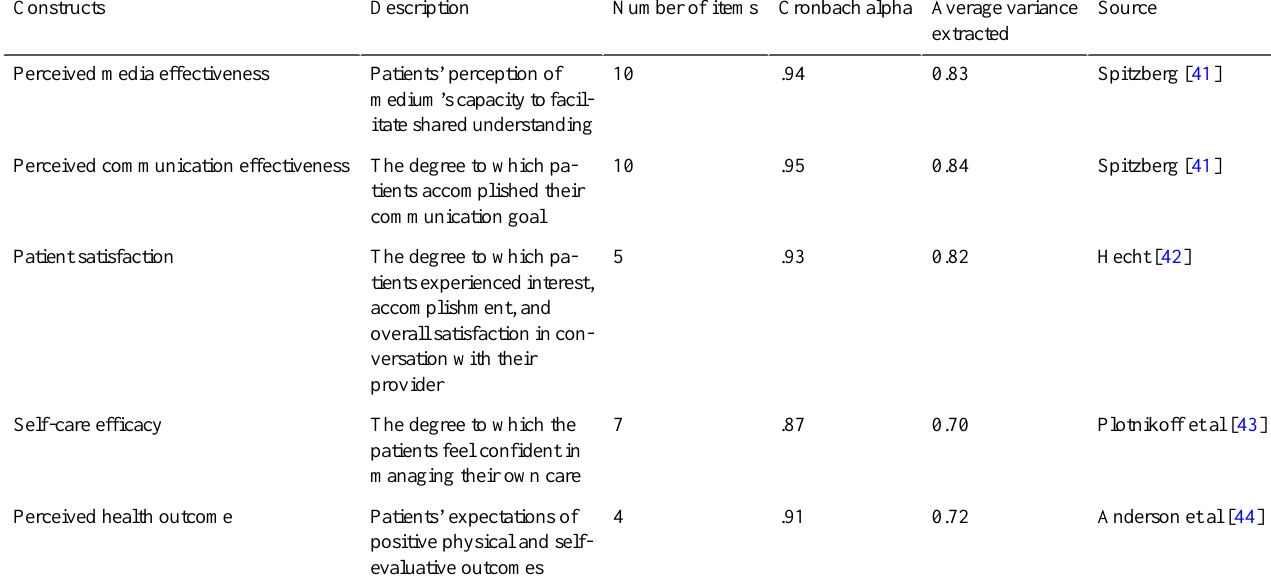
Table 1. Psychometric properties of measurement